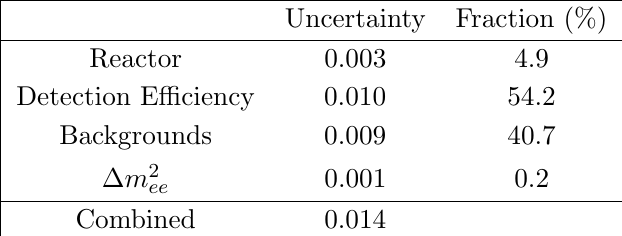
Table 6 . Systematic errors from uncertainty sources. The dominant source of the systematic error for sin 2 2 (cid:18) 13 is the detection e(cid:14)ciency.